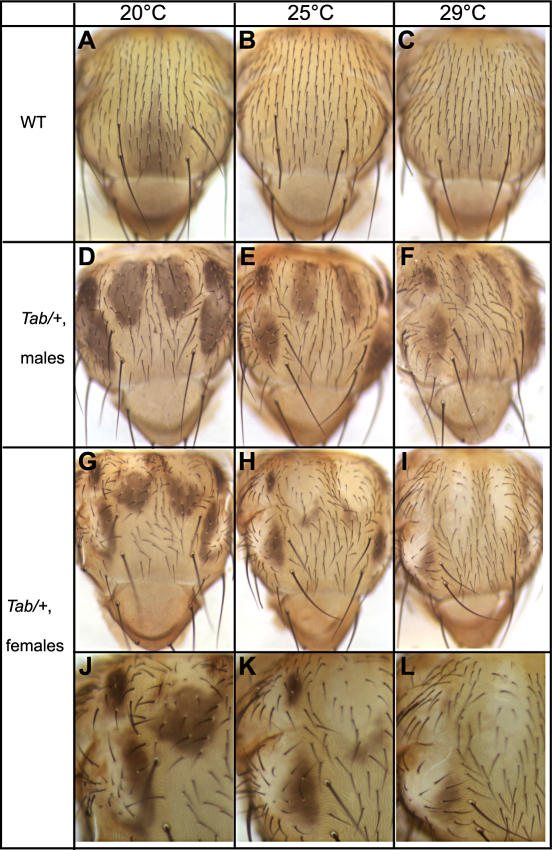
Ectopic Expression of Abd-B on the Thorax Is Sufficient to Generate a Sex-Specific Plastic Pigmentation PatternEffect of temperature on the pigmentation pattern generated by the ectopic thoracic expression of Abd-B in the mutant Transabdominal (Tab) [17] in males (D–F) and females (G–L).In wild-type flies (A–C), the pigmentation is homogenous in both sexes except for the trident pattern visible at extreme developmental temperature (A). Ectopic expression of Abd-B on the thorax is sufficient to generate a highly plastic pigmentation pattern in females (G–L).